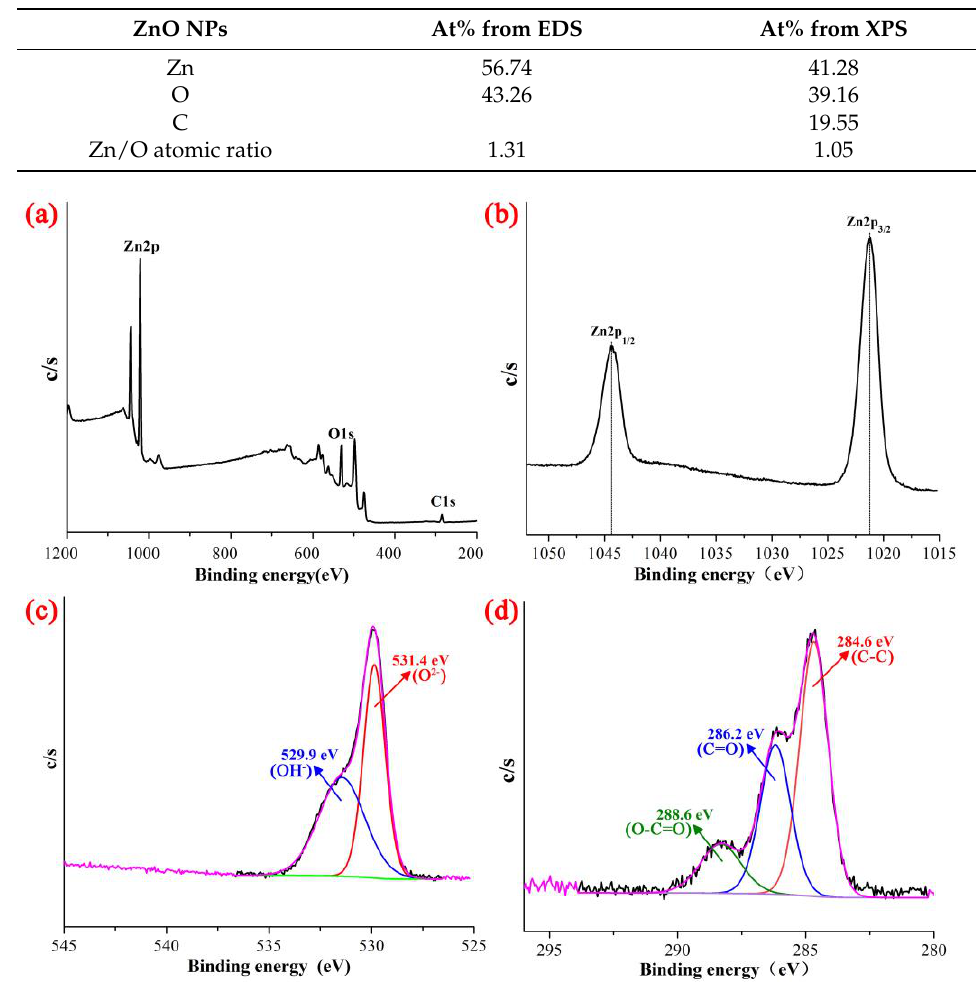
Table 1. Elementary composition of ZnO NPs according to EDS and XPS.